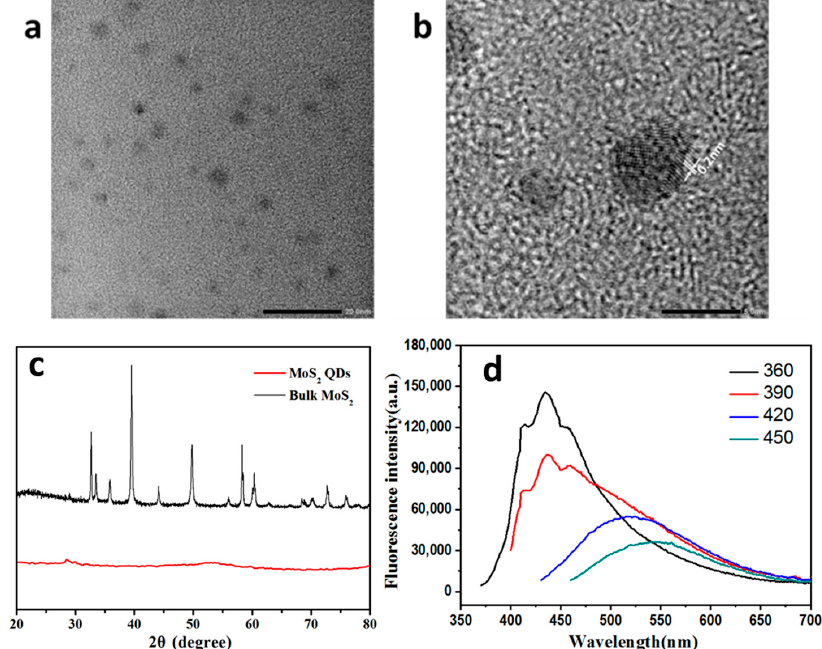
Figure 2. ( a ) TEM pattern of MoS 2 quantum dots (QDs); ( b ) partial enlarged drawing of ( a ); ( c ) XRD pattern of MoS 2 QDs; ( d ) fluorescence spectrum of MoS 2 QDs.